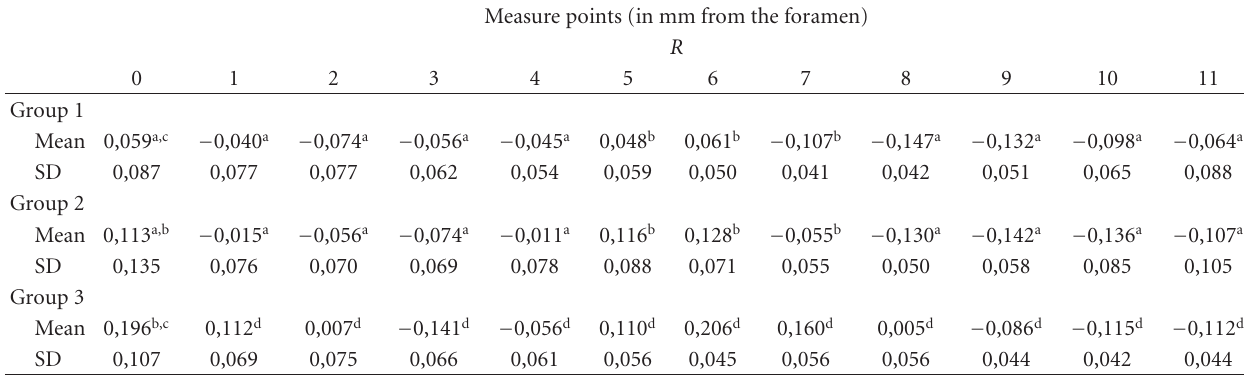
Table 2: Centering ratio means and Standard Deviation (SD) at the di ff erent levels in groups 1, 2, and 3. Measure points (in mm from the foramen)